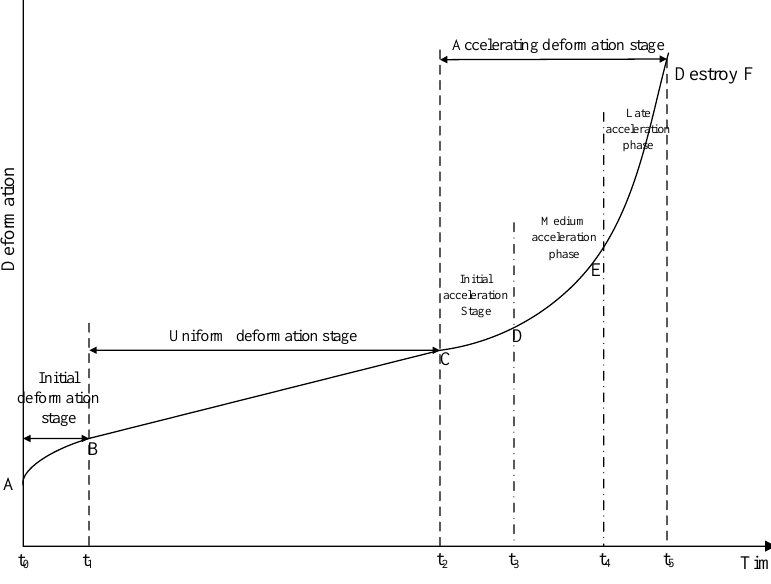
Figure 8. Sketch of three stages of slope deformation.